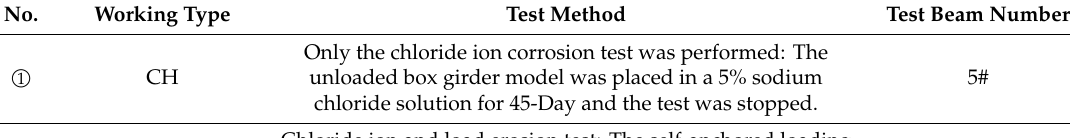
Table 1. Chloride ion erosion test conditions and specimen grouping of box girder